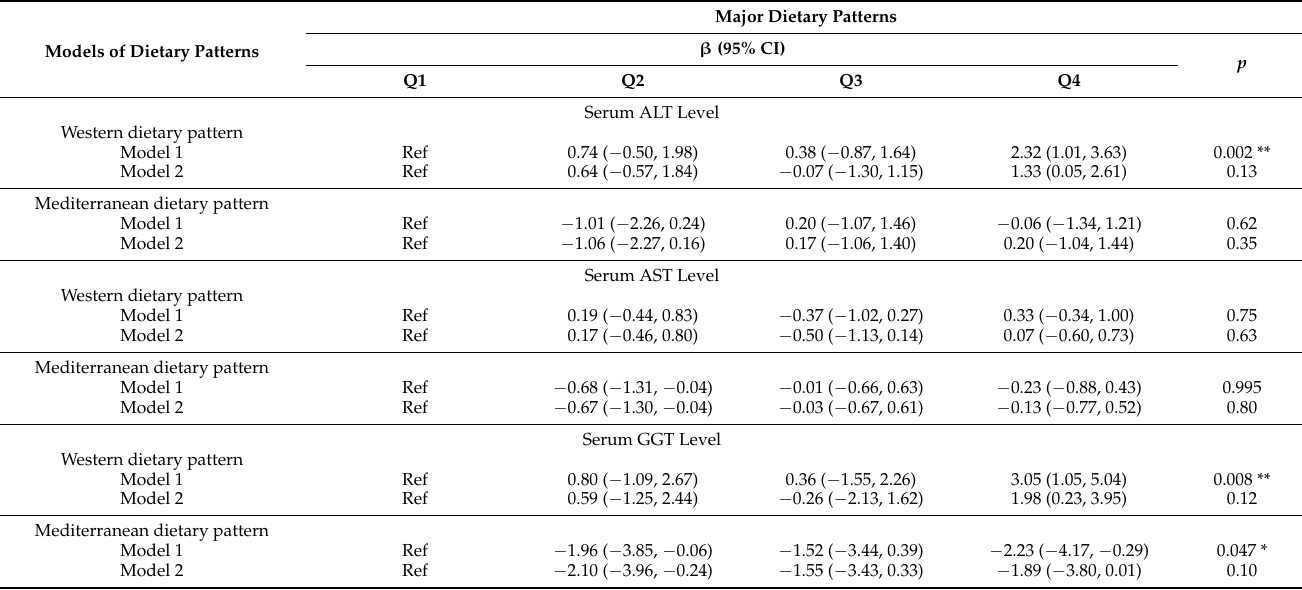
Table 4. Multivariable linear regression analysis of serum hepatic enzyme levels across quartiles of major dietary patterns ( n = 15,005) 1